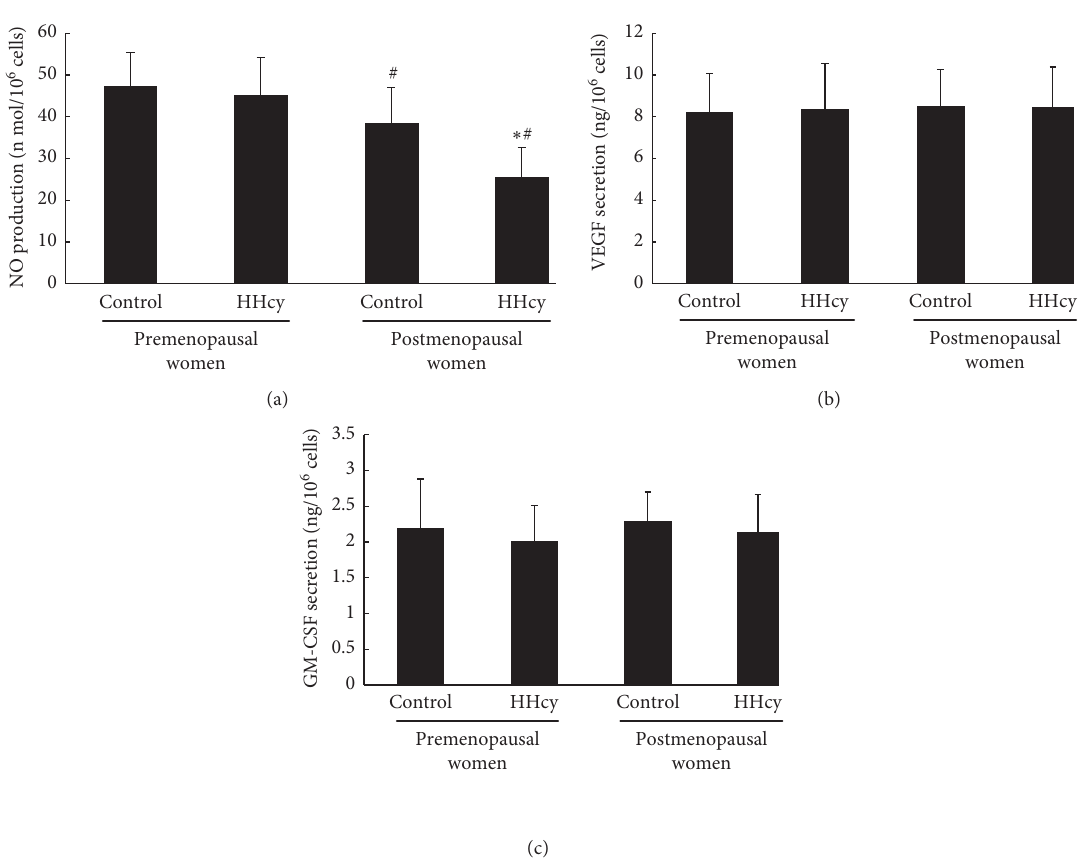
Figure 4: The NO, VEGF, and GM-CSF secretion by EPCs in the four groups was showed as follows. (a) The NO secretion by EPCs in postmenopausal women was lower than that in premenopausal women. No difference in NO secretion by EPCs between control and hyperhomocysteinemia premenopausal women was found. However, the NO secretion level in hyperhomocysteinemia postmenopausal women was lower than that in control. (b) There was no significant difference in VEGF secretion by EPCs between the four groups. (c) There was no significant difference in GM-CSF secretion by EPCs between the four groups. Data are given as mean ± SD. ☆ vs. control; # vs. premenopausal